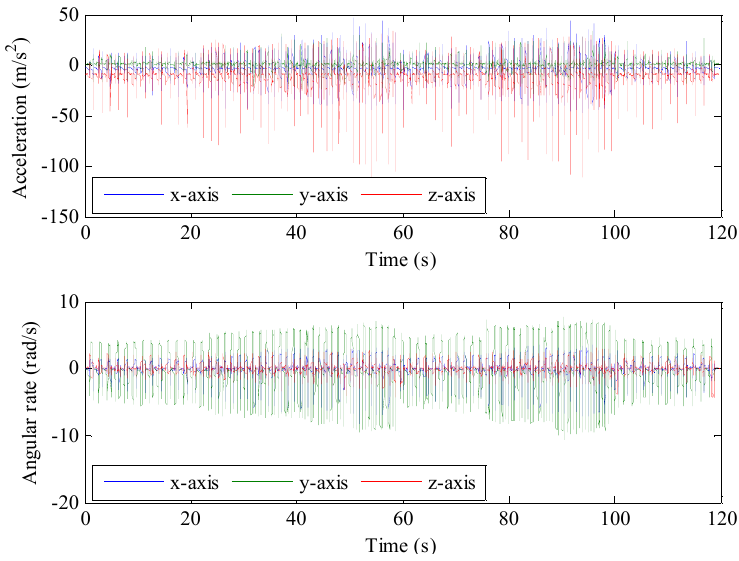
Figure 13. Output of the IMU during walking.